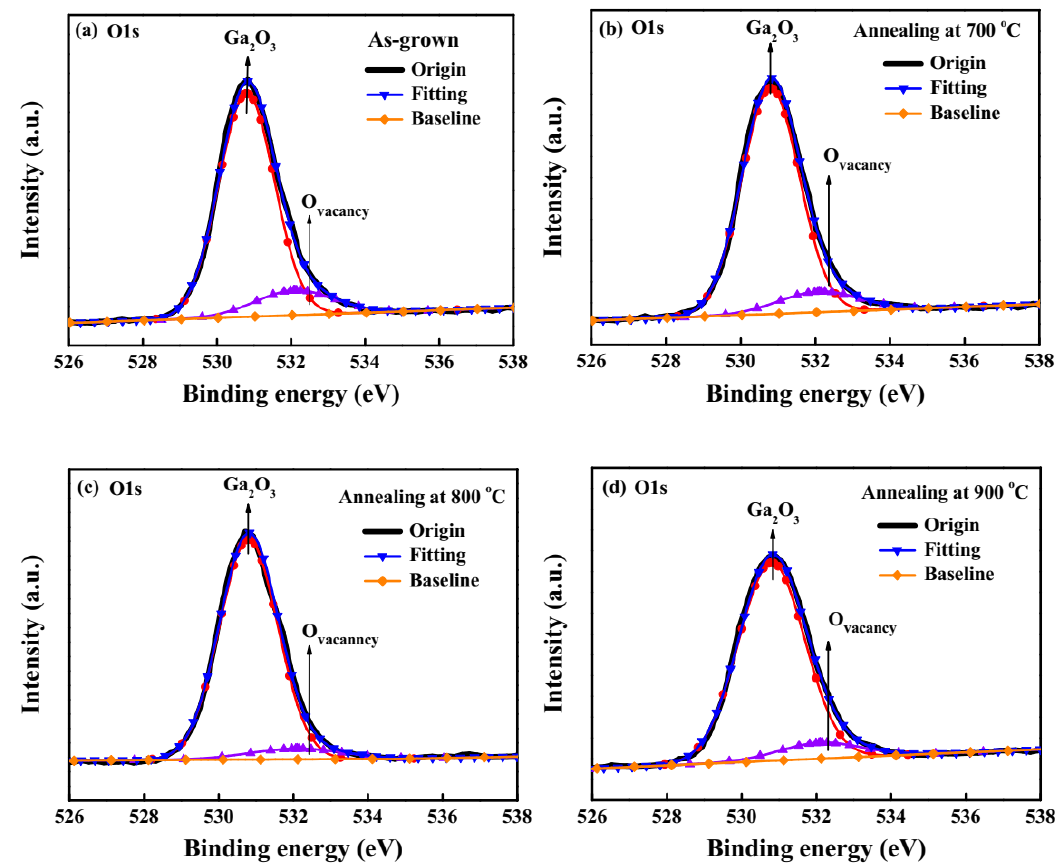
Figure 3. X-ray photoelectron spectroscopy (XPS) spectra of O1s core level spectra of ( a ) as-grown Ga 2 O 3 films and Ga 2 O 3 films annealed at ( b ) 700 ◦ C, ( c ) 800 ◦ C, and ( d ) 900 ◦